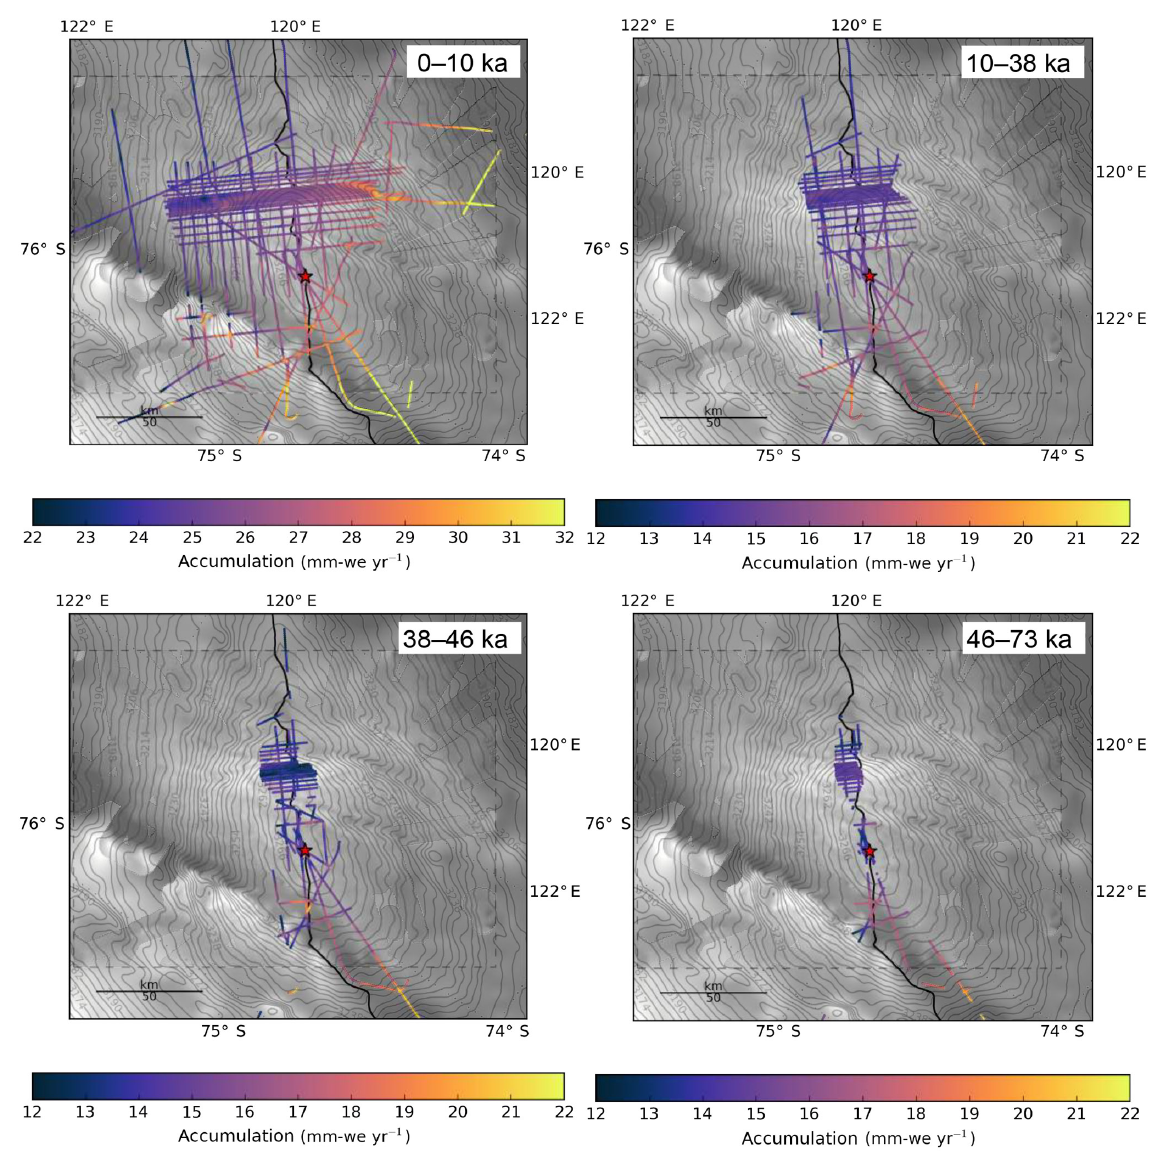
Figure 4. Paleoaccumulation reconstruction over the Dome C region since 73ka. Panels show paleoaccumulation rates calculated for each isochrone-bounded layer, age intervals are given on each panel. Results are filtered to remove regions of excess horizontal strain. The north– south accumulation rate gradient, decreasing with distance from the Indian Ocean coastal sector, remains stable for the last 73ka. Background is the same as in Fig.